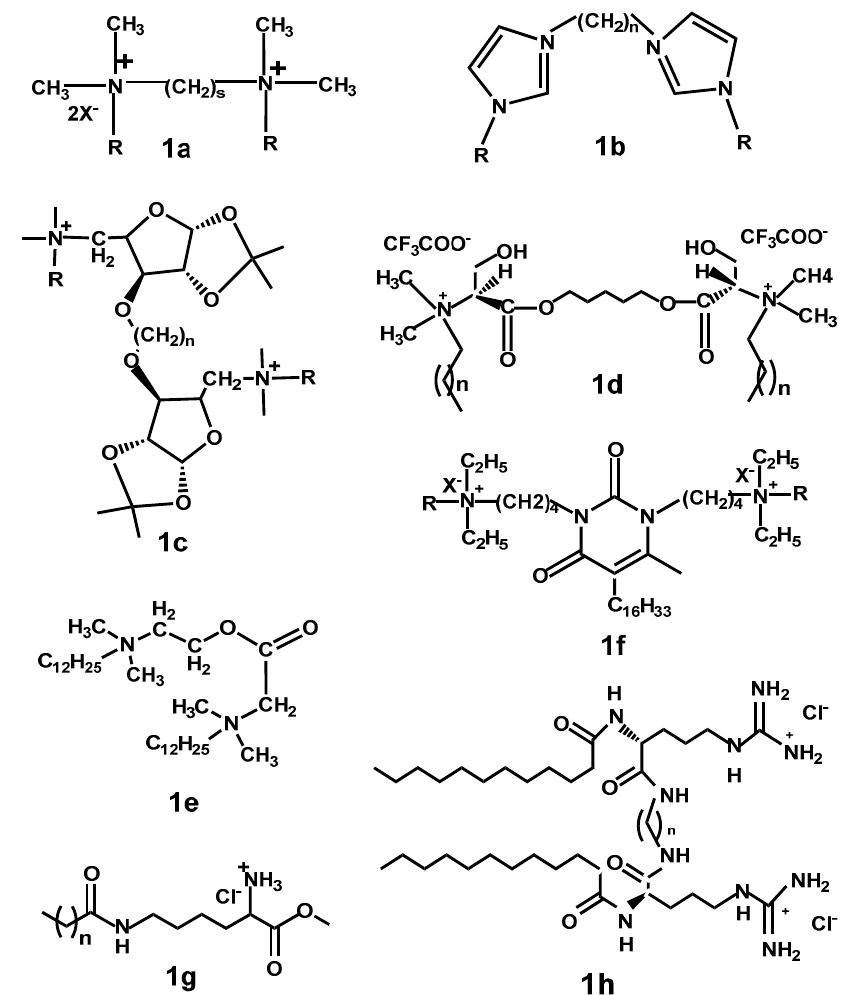
Figure 1. Examples of cationic quaternary ammonium surfactants, 1a: R = C n H n + 1 , s = 4; 1b: R = C n H n + 1 , n = 2,4; 1c : R = C 12 H 25 , C 16 H 37 , C 18 H 37 , n = 3; 1d : n = 10; 1f: R = C 10 H 21 , X − = Br − ; 1g : n = 10, 12, 14; and 1h : n = 6, 9, 12.